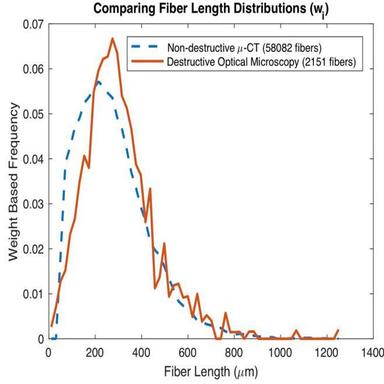
Comparison of the weight fiber length distributions determined nondestructively and destructively.